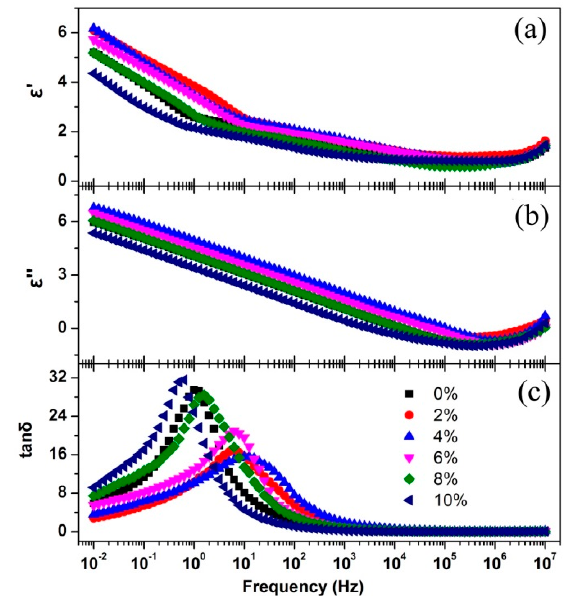
Figure 7. The frequency dependence of ε′ ( a ), ε″ ( b ) and tan δ ( c ) with different Eu 3+ doping concentration.